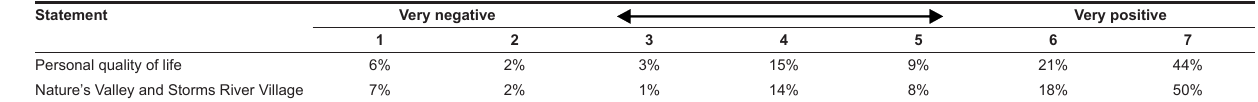
TABLE 1 The influence of the Tsitsikamma National Park on the